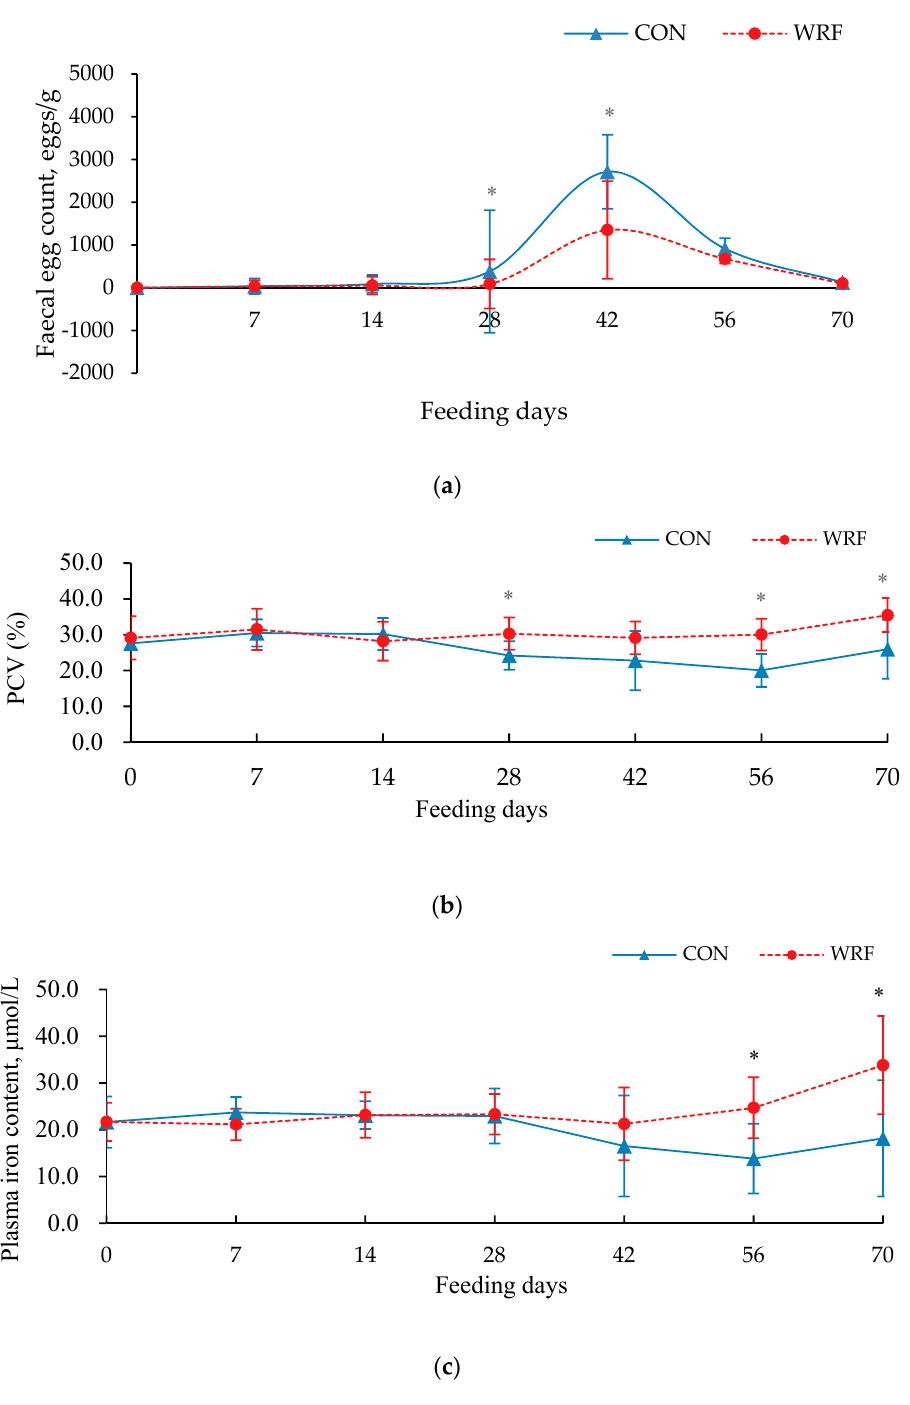
Figure 2. Mean ± SEM e ff ects of dietary-fungal-pretreated corn straw on ( a ) fecal egg count (FEC), ( b ) packed cell volume (PCV, lower panel) and ( c ) plasma iron content (upper panel) of lambs infected with gastrointestinal nematodes; di ff erence between treatments (* p < 0.05).